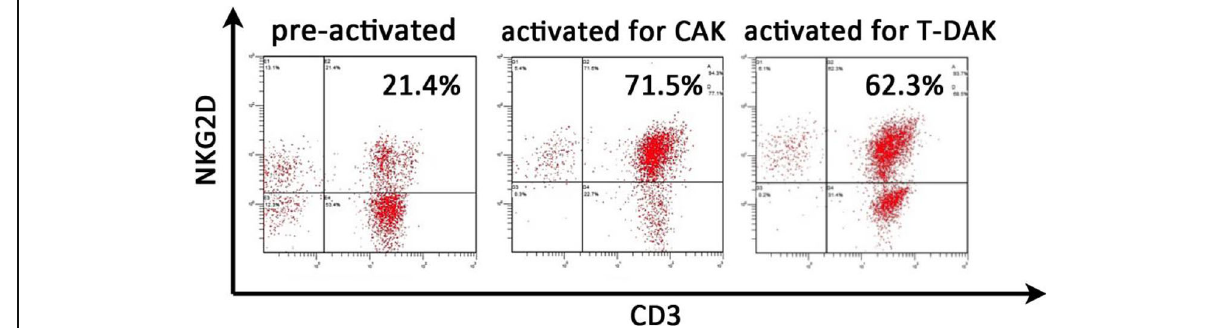
Fig. 3 Representative histogram of natural-killer group 2, member D (NKG2D) expression on lymphocytes before and after stimulation. NKG2D expression levels on lymphocytes before and after activation were analyzed by fluorescence-activated cell sorting. Activation resulted in a notable increase in NKG2D expression on CAK and T-DAK